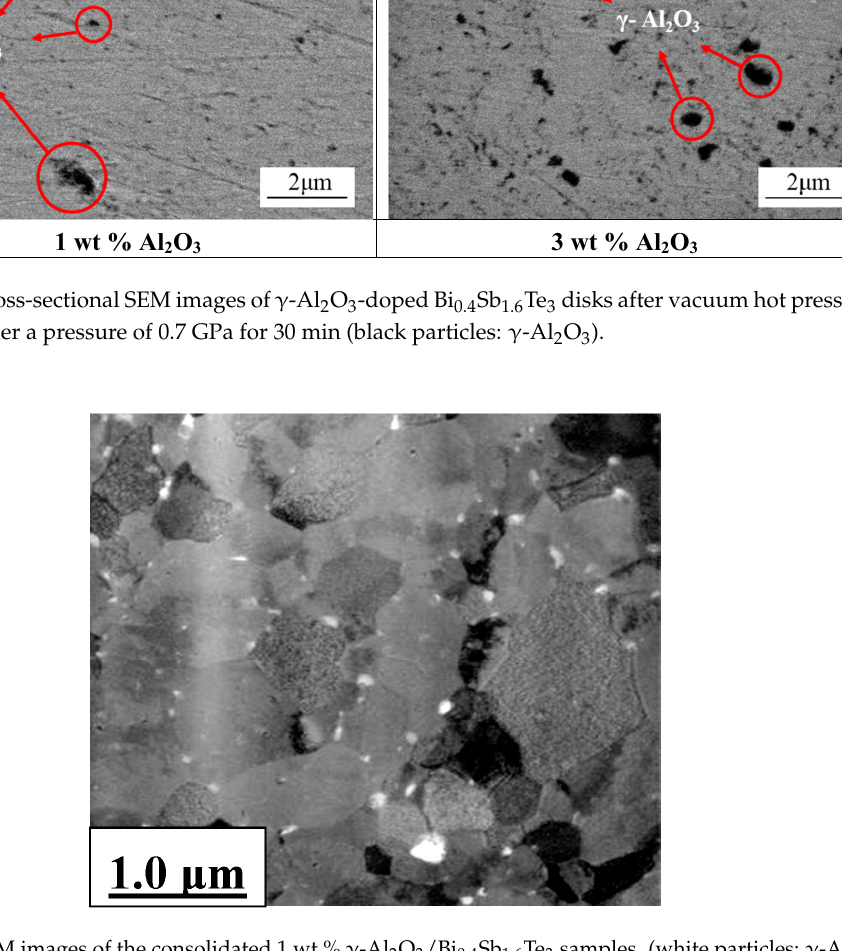
Figure 4. TEM images of the consolidated 1 wt % γ -Al 2 O 3 /Bi 0.4 Sb 1.6 Te 3 samples. (white particles: γ -Al 2 O 3 ).